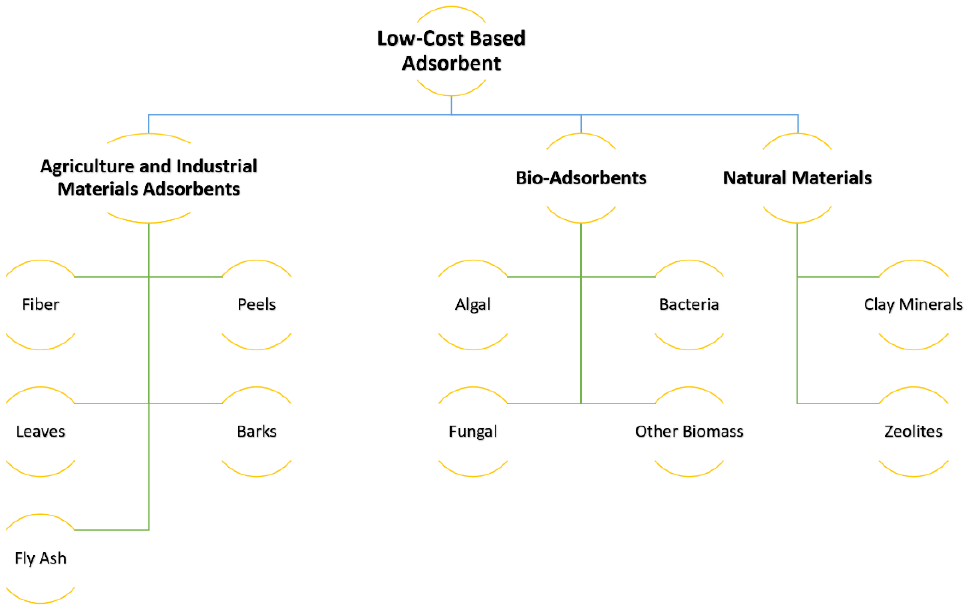
Figure 3. Numerous inexpensive adsorbents ’ capacities for dye (MB)